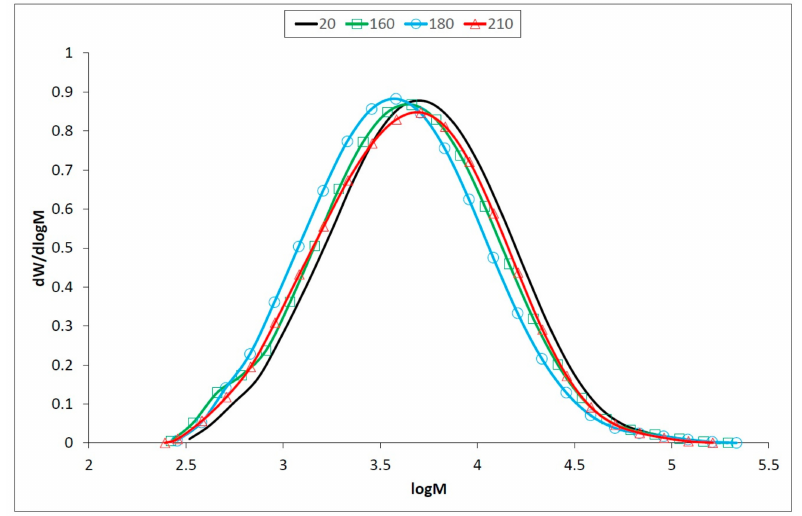
Figure 4. Molecular weight distribution of oak wood lignin before and after thermal